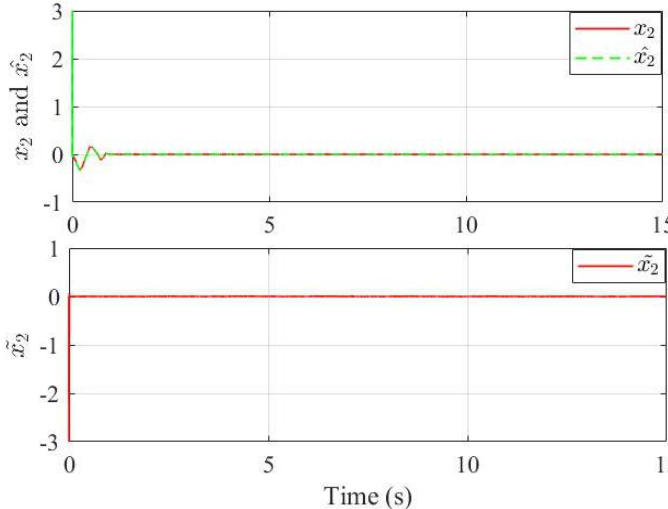
Figure 11. Estimation of x 2 and estimation error.